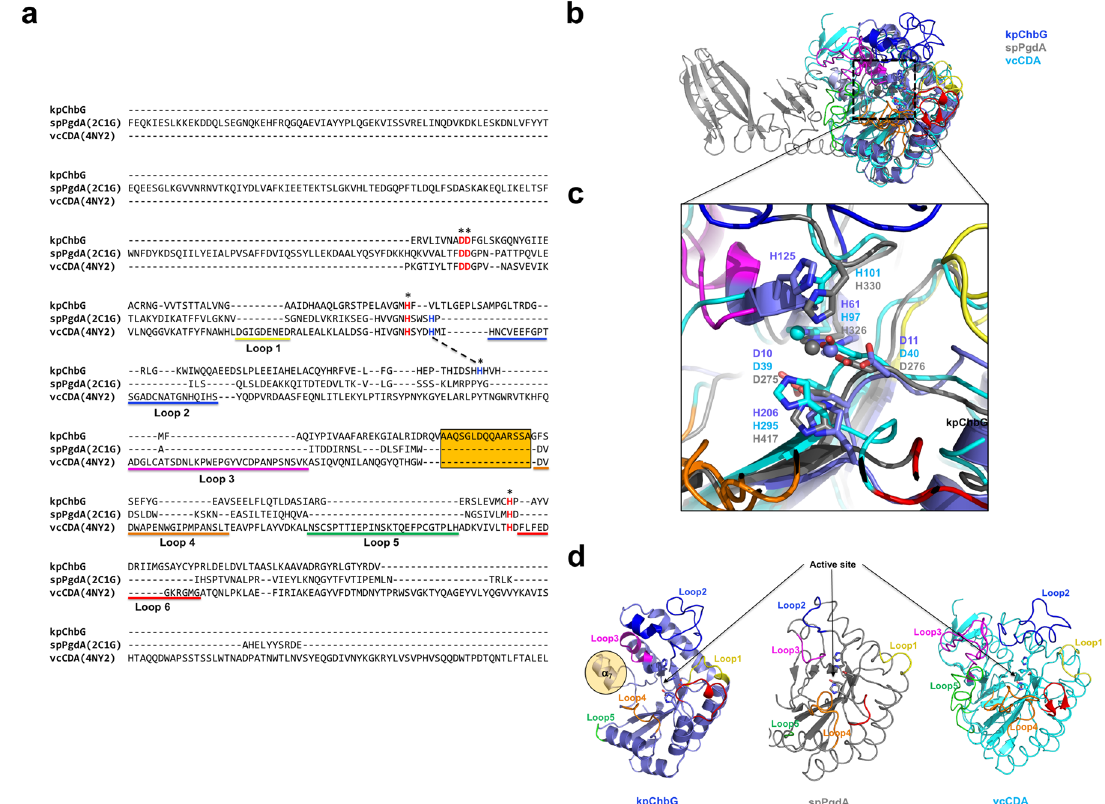
Fig. 5 Comparison of kpChbG with other CE4 enzyme family members. a Sequence alignment based on structural alignment using PROMALS3D. The fi ve residues forming the active site, which are critical for activity of CE4 enzymes, are indicated by asterisks (*). Four of the fi ve residues forming the active site structurally aligned with each other are shown in red, whereas one residue, H125 on kpChbG, which does not structurally aligned, is shown in blue. The putative corresponding histidine residue with H125 of kpChbG, identi fi ed by locating the similar position in the active site of the CE4 enzyme, is linked by a dashed black line. Six loops (Loop 1~6) involved in the substrate speci fi city control as characterized in CE4 enzymes are indicated by colored lines under the corresponding residues. Residues used to form α 7 helix in kpChbG are highlighted using orange color. b Structural superposition of kpChbG (light blue) with spPgdA (gray) and vcCDA (cyan). c Magni fi ed region of the active site that is marked by a black-dashed box in b . Conserved residues involved in the formation of the active site are labeled. d Structural comparison of six loops in kpChbG with those of other CE4 enzymes. α 7 helix, which is only present in kpChbG, is indicated by an orange-colored